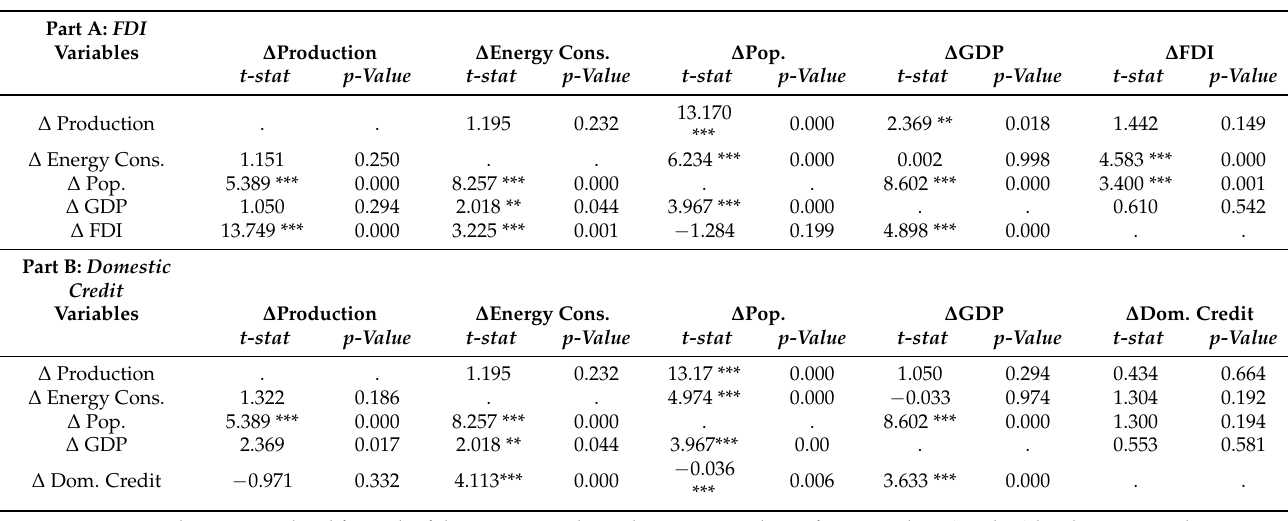
Table 6. Short run relationship based on granger causality